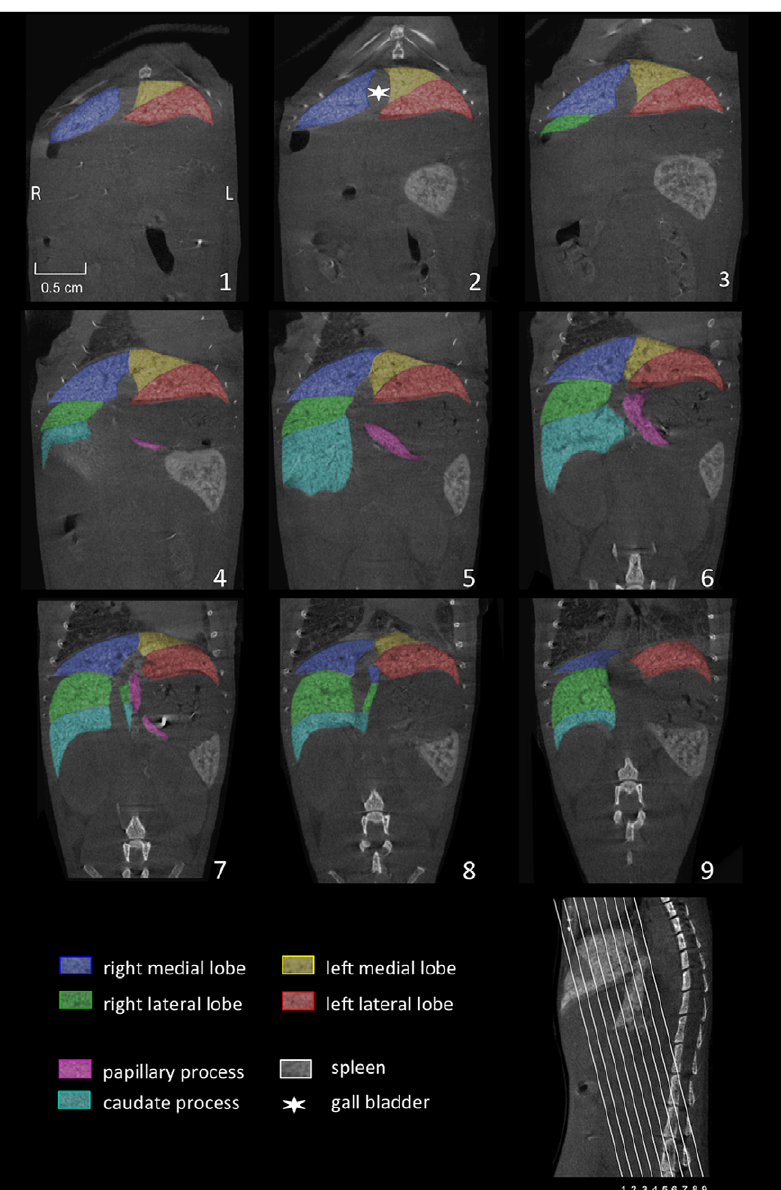
Figure 2. Coronally reconstructed micro-CT images. Imaging of the liver of a C57BL/6J mouse was performed 3 hours after i.v. injection of 100 m l of a nanoparticular contrast agent (ExiTron nano 12000). The color-coding of the single liver lobes corresponds to the color coding presented in Figure 1. The slice orientation in relation to the spine is shown in the lower right corner.